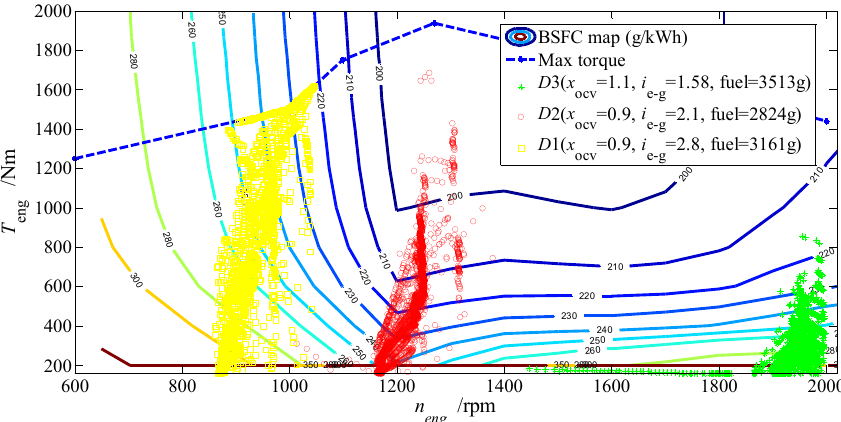
Figure 8. Engine operating points in three different parameter selection ( x